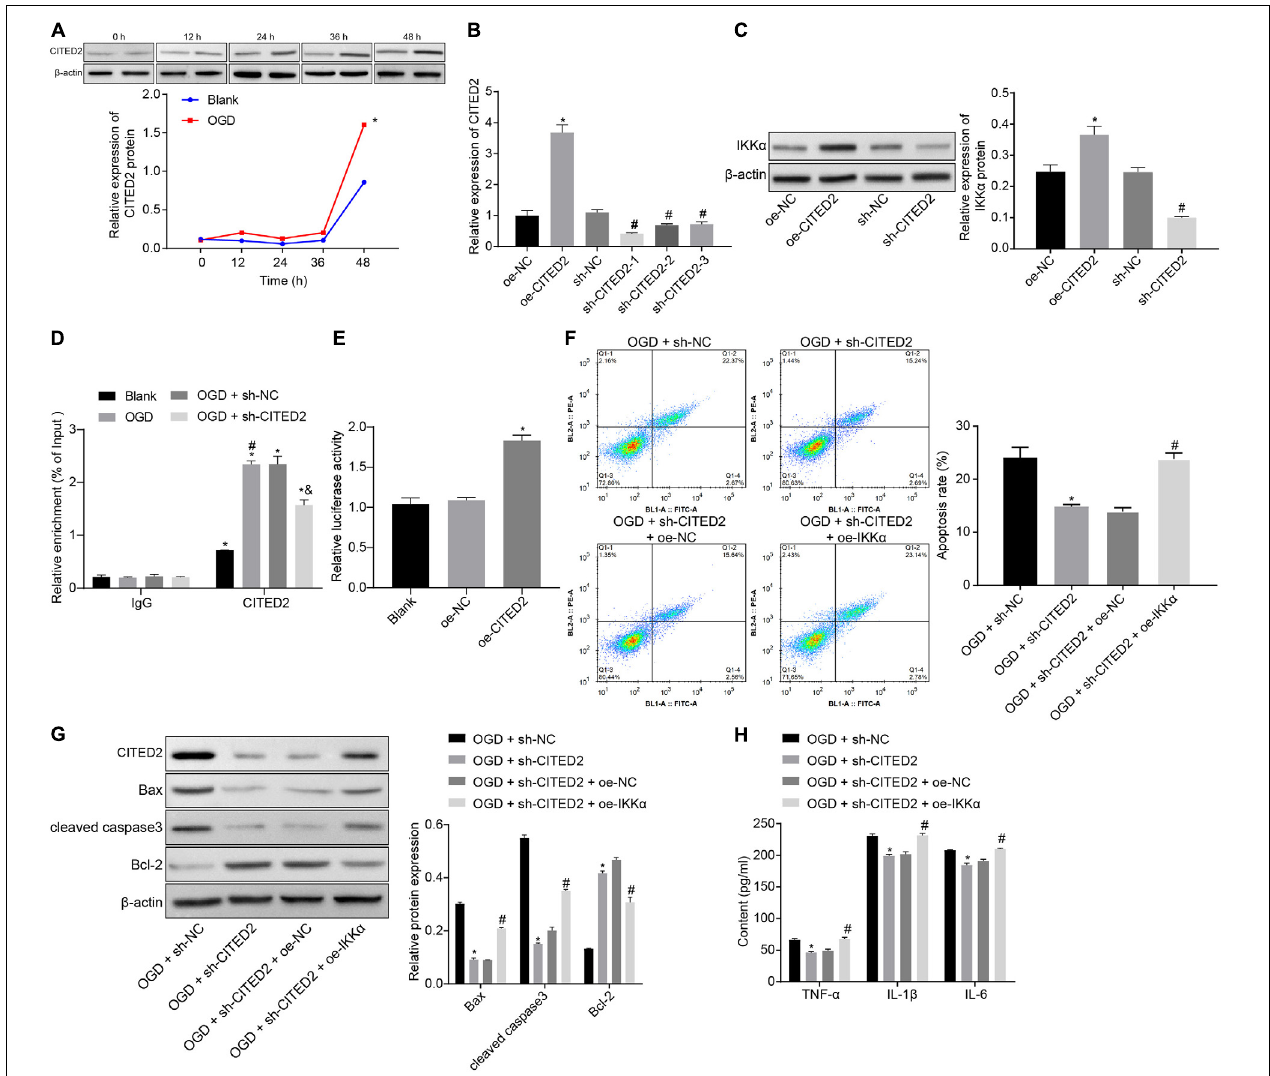
FIGURE 3 | CITED2 upregulates IKK α expression to facilitate OGD-induced neuronal cell apoptosis. (A) The protein expression of CITED2 normalized to β -actin at different time points after OGD treatment measured by western blot analysis. (B) The mRNA expression of CITED2 in neuronal cells determined by RT-qPCR after overexpression or knockdown of CITED2. (C) The protein expression of IKK α normalized to β -actin after overexpression or knockdown of CITED2 measured by western blot analysis. (D) The enrichment of CITED2 protein in the promoter region of IKK α detected by ChIP assay in neurons. (E) The effect of overexpression of CITED2 on the transcriptional activity of the IKK α promoter region detected by a dual-luciferase reporter gene assay. (F) The apoptosis of neurons examined by flow cytometry. (G) Western blot analysis for the determination of the expression of apoptosis-related proteins (cleaved caspase 3, Bax, Bcl-2, and caspase 3 expression) normalized to β -actin in neurons. (H) Expression of inflammatory cytokine (TNF- α , IL-1 β , and IL-6) in cell supernatant determined by ELISA. In panel (A) , * p < 0.05 vs. the blank group (neuronal cells without OGD treatment). In panels (B,C) , * p < 0.05 vs. neuronal cells treated with oe-NC. In panel (D) , * p < 0.05 vs. neuronal cells treated with IgG; # p < 0.05 vs. blank group (neuronal cells without OGD treatment); & p < 0.05 vs. OGD-exposed neuronal cells treated with sh-NC. In panel (E) , * p < 0.05 vs. neuronal cells treated with oe-NC. In panels (F–H) , * p < 0.05 vs. OGD-exposed neuronal cells treated with sh-NC; # p < 0.05 vs. OGD-exposed neuronal cells treated with sh-CITED2 and oe-NC. Measurement data were expressed as mean ± standard deviation. Unpaired data in compliance with normal distribution and homogeneity between two groups were compared using an unpaired t -test. Comparisons among multiple groups were conducted by one-way ANOVA with Tukey’s post hoc test. Data at different time points were compared by repeated-measures ANOVA, followed by Bonferroni’s post hoc test. The experiment was repeated three times